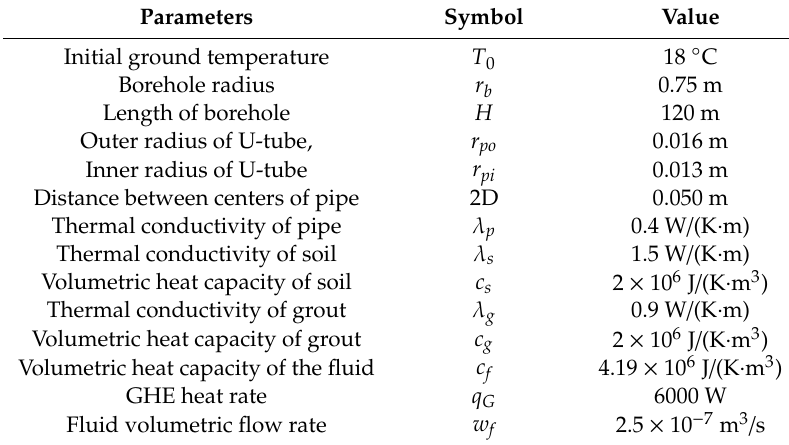
Table 2. Benchmark values of the parameters of GHE with a single U-tube.